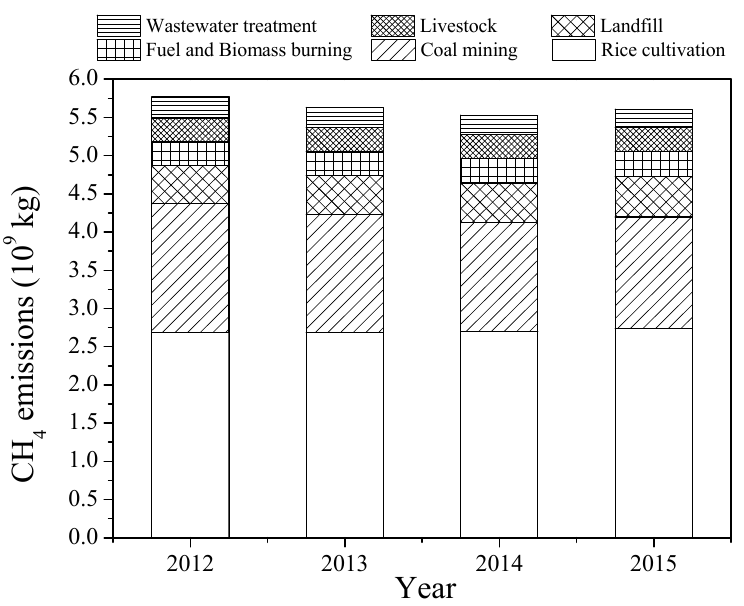
Figure 11. Annual anthropogenic CH 4 emissions from different sectors in the YRD from 2012 to 2015, based on the IPCC inventory method.